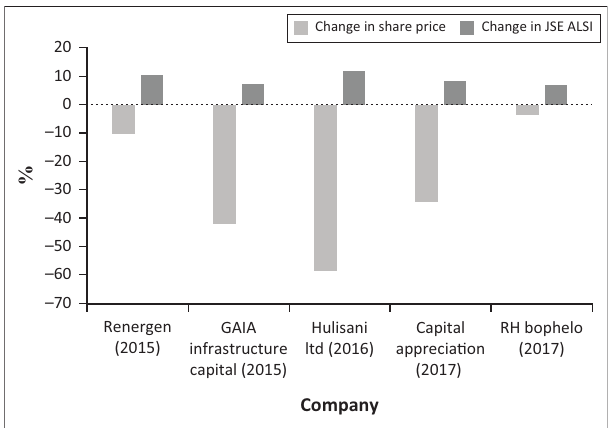
FIGURE 2: Share price performance relative to the Johannesburg stock exchange all share index.